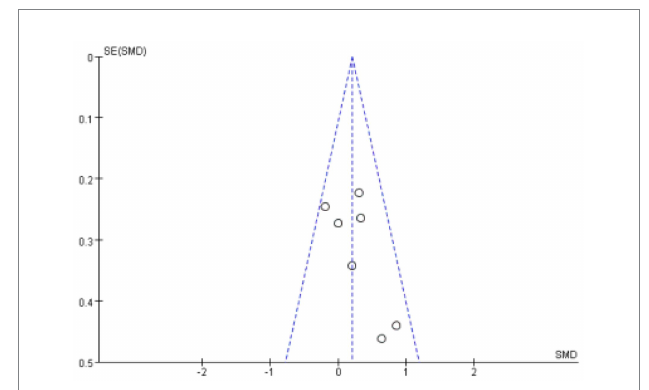
FIGURE 10 Funnel plots of muscular